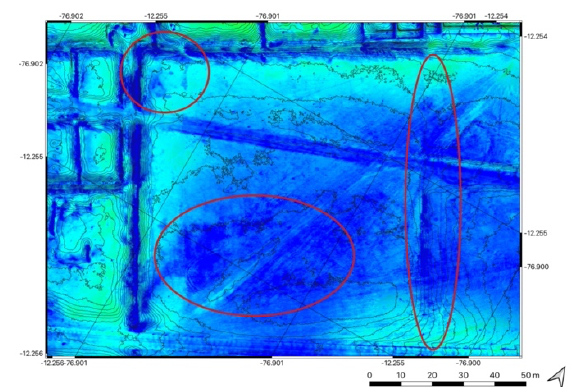
Figure 16 . Crossed results of the various surveys of zone D with highlighting of potential buried structures